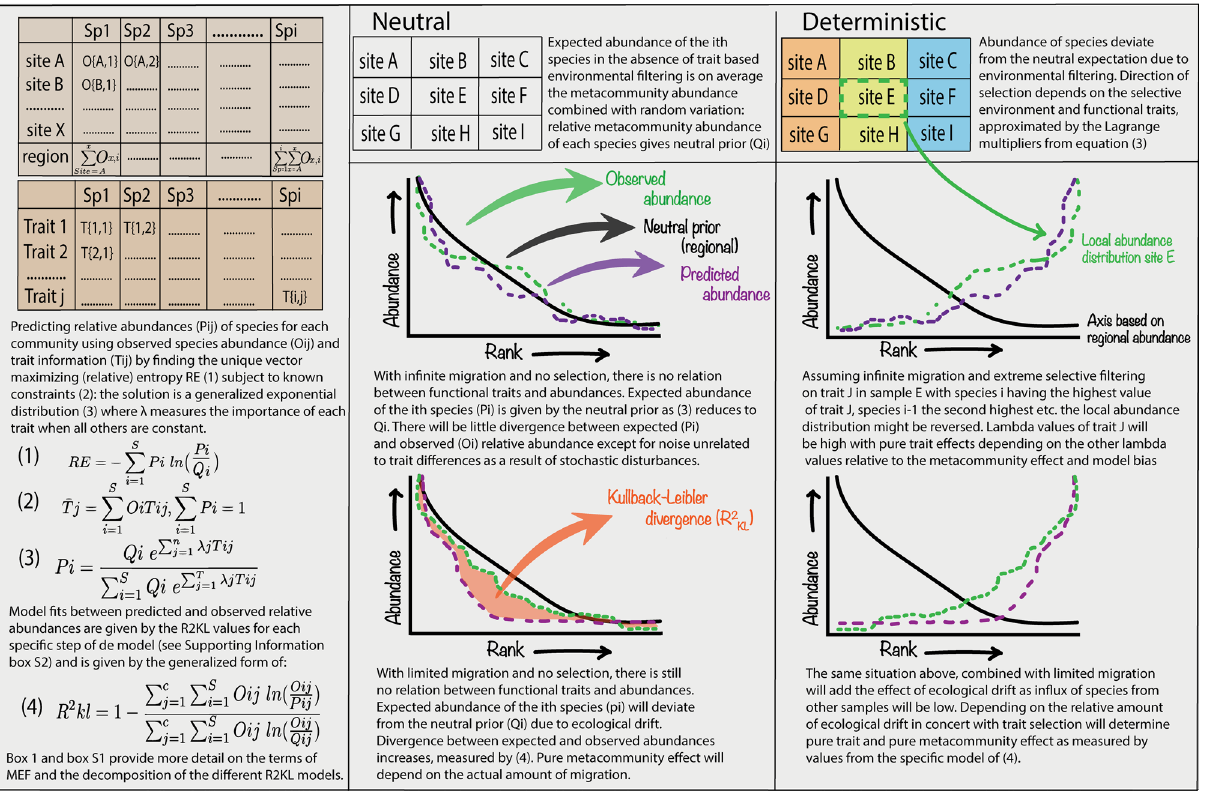
Figure 1. Schematic depiction of the MEF procedure. Left panel shows a genus abundances per site and a functional trait matrix per genus, bottom half outlines calculations. Middle and right panel show different scenarios of neutral and deterministic dynamics under infinite or limited migration. Figure was custom made using Adobe Illustrator (Adobe Inc., 2019. Adobe